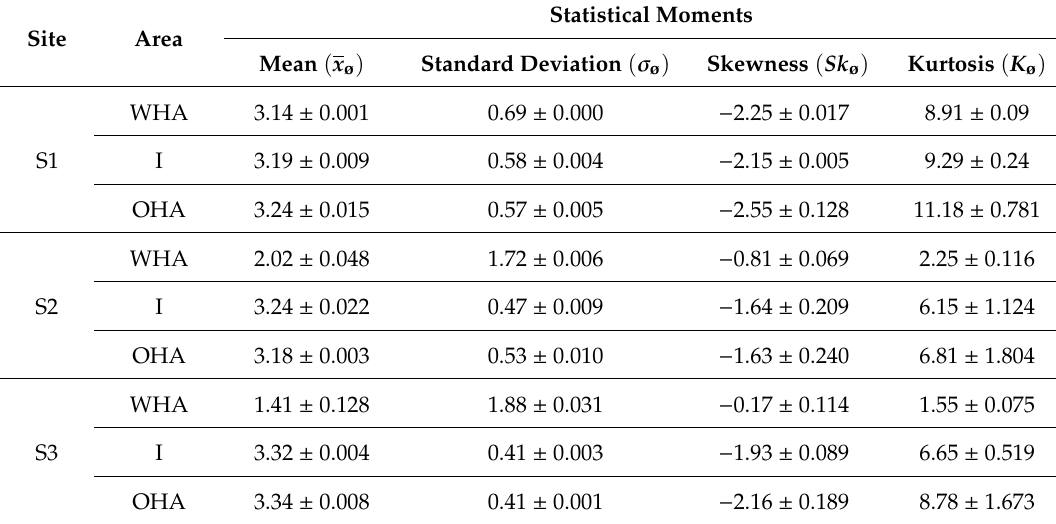
Table 3. Average values of the statistical moments of each area in each study site with its standard error, of the sediments collected on 13 December, 2017. WHA, area with hydrothermal activity; I, intermediate area; OHA, out of hydrothermal activity